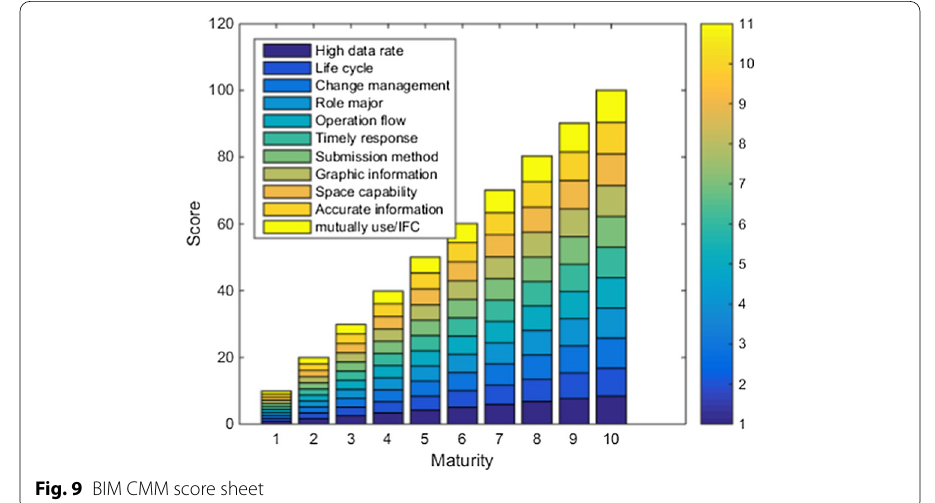
Fig. 9 BIM CMM score sheet